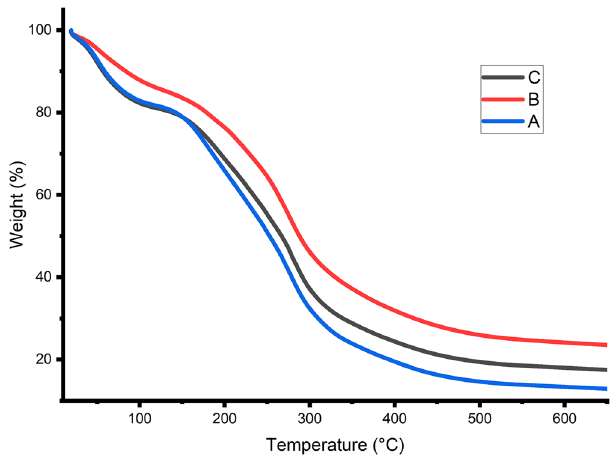
Figure 5. Thermogravimetric analysis (TGA) of sample A, sample B, and sample